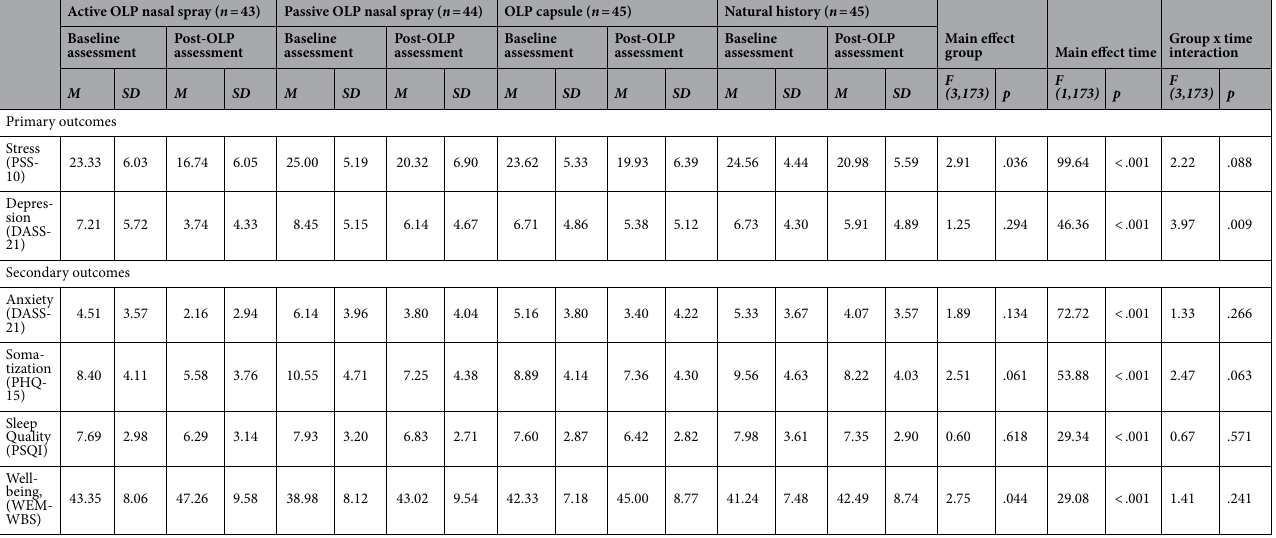
Table 2. Primary and secondary outcomes at baseline and post-OLP intervention per group, main effects (group, time) and group x time interaction. M mean; SD standard deviation; n number of participants; PSS-10 Perceived Stress Scale (ranging from 0 to 40); DASS-21 Depression Anxiety and Stress Scale (each scale ranging from 0 to 21); PHQ-15 Somatization scale from the Patient Health Questionnaire (ranging from 0 to 30); PSQI Pittsburgh Sleep Quality Index (ranging from 0 to 21); WEMWBS Warwick–Edinburgh Mental Wellbeing Scale (ranging from 14 to